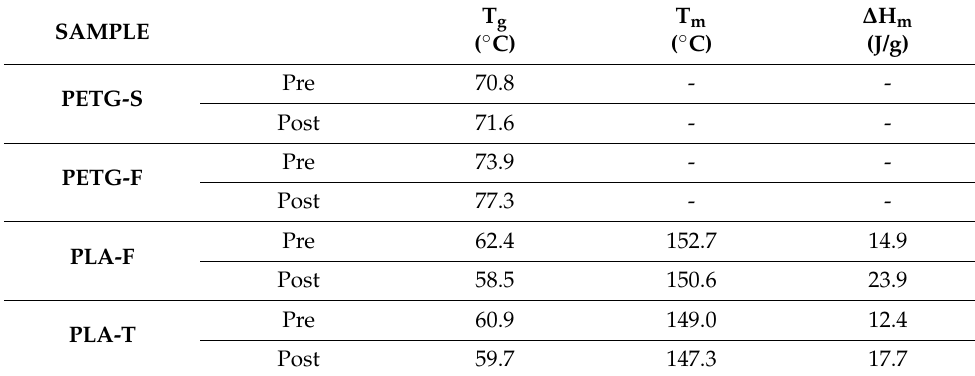
Figure 4. DSC analysis of PETG and PLA pre- and post-processed samples. Table 2. Properties of the considered